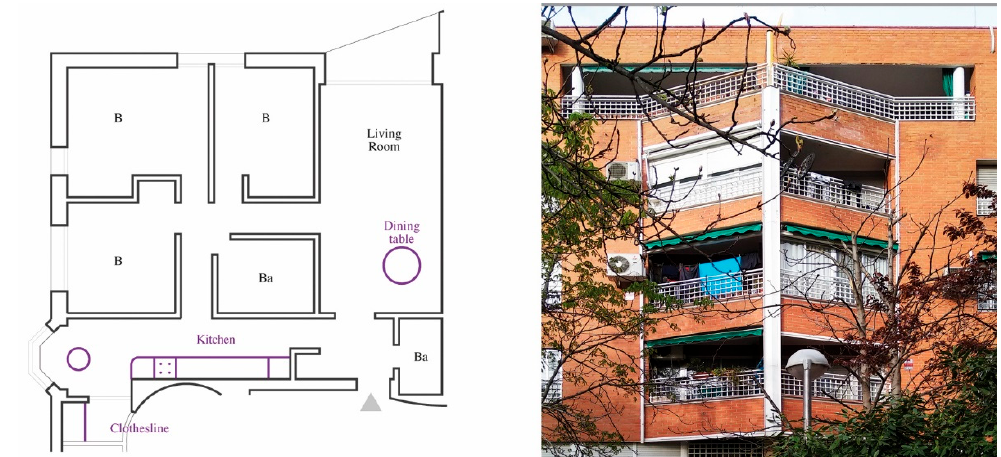
Figure 10. IVIMA housing complex in Palomeras North, UV 10 mega-block. Three-bedroom apartment. Plan redrawn and photo by author.